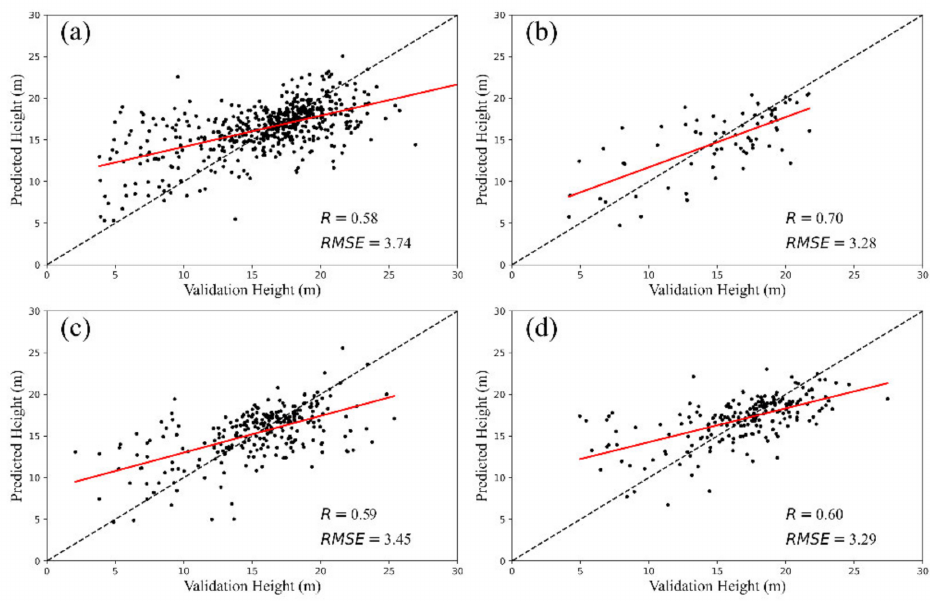
Figure 4. Correlations between the validation samples and predicted forest canopy heights by